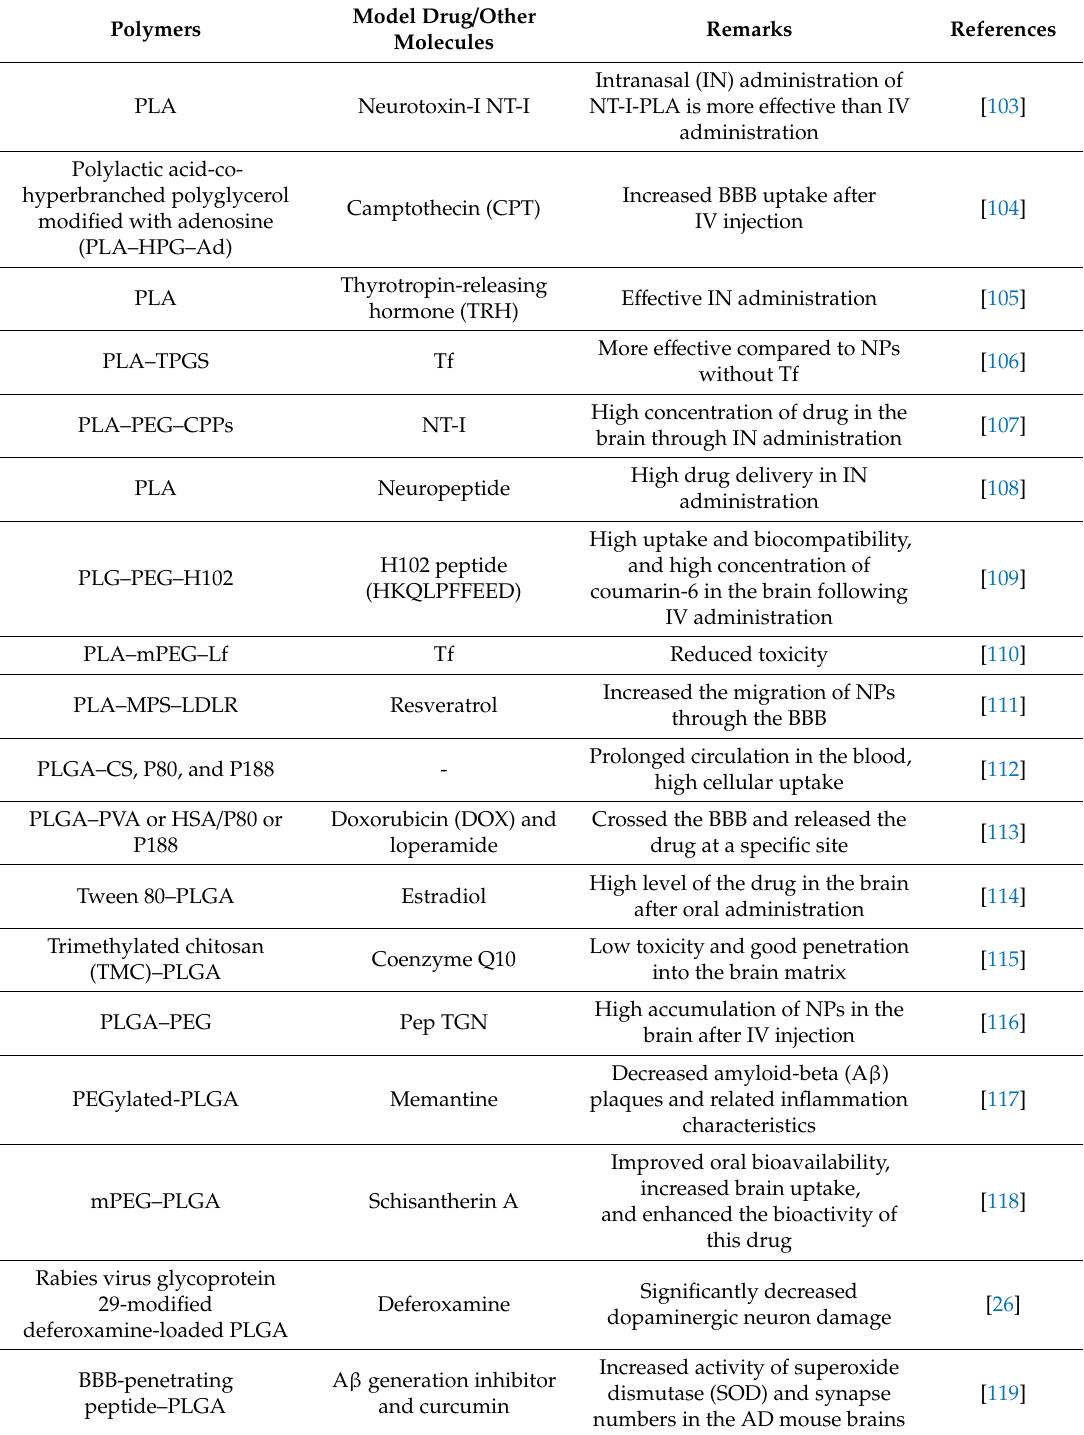
Table 1. Some selected polymeric NPs for the delivery of drugs to the